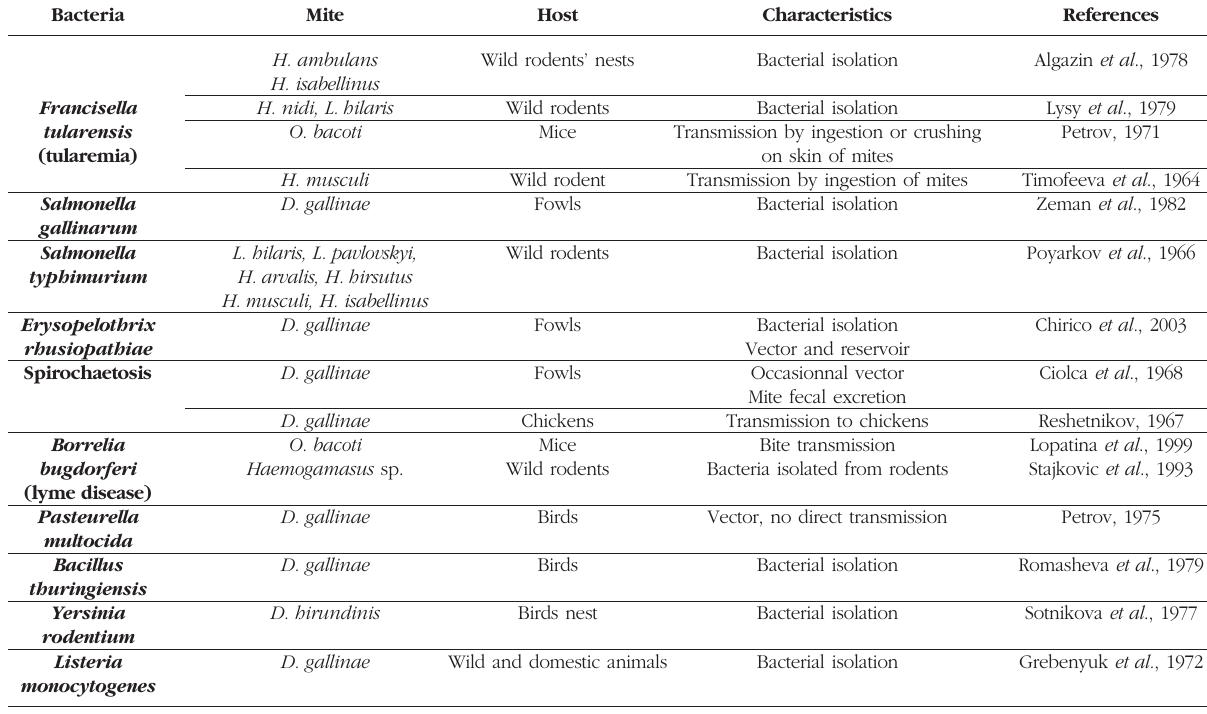
Table III. – Bacteria likely to be transmitted by dermanyssoid mites ( Rickettsia and Coxiella are shown in Table VI). ( D. hirundinus = Der- manyssus hirundinis, H. ambulans = Haemogamasus ambulans, H. arvalis = Hyperlaelaps arvalis, H. isabellinus = Hirstionyssus